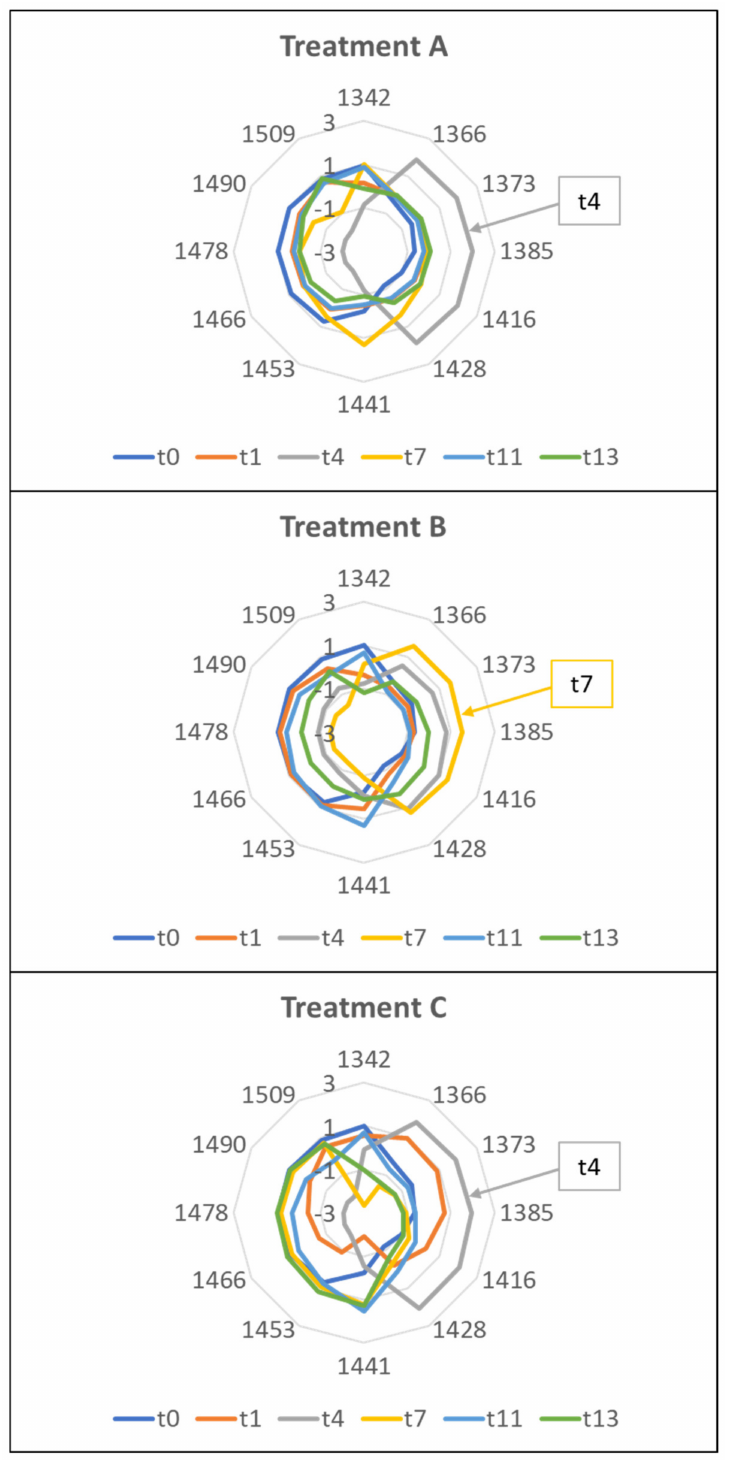
Figure 10. Aquagrams of the rocket samples belonging to the three treatments during the storage: Trial